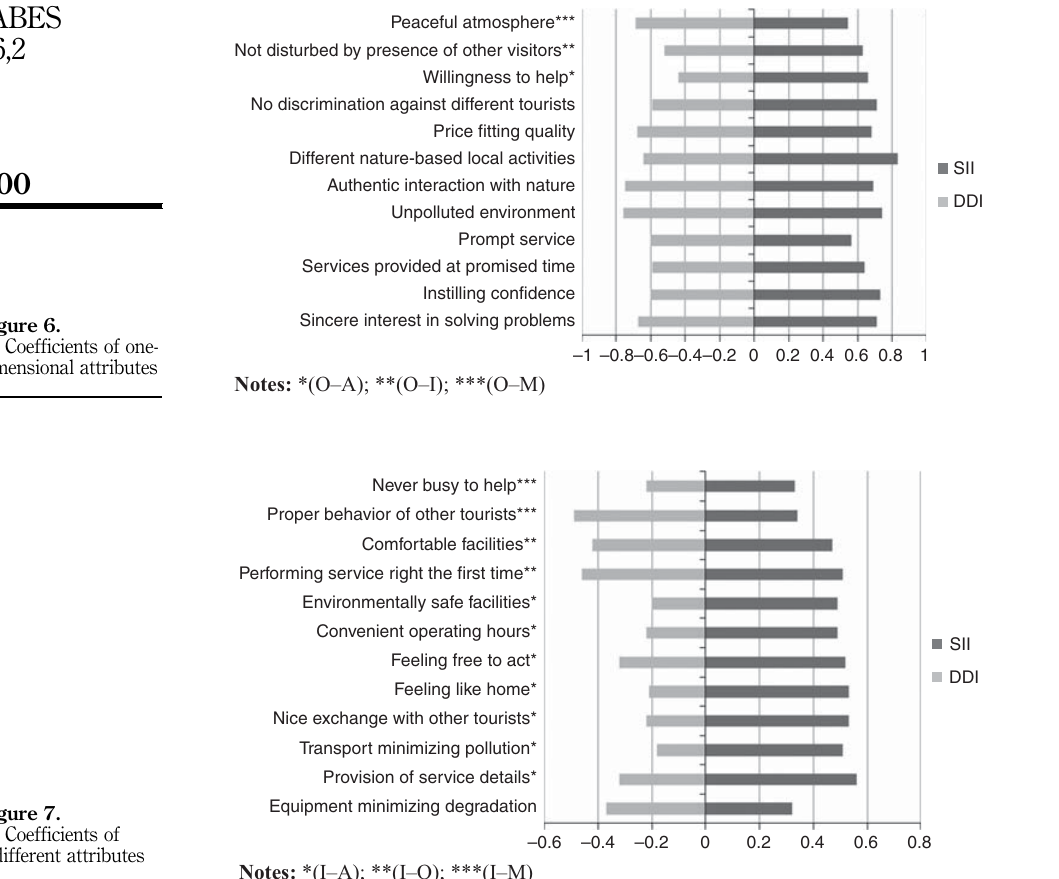
Figure 7. CS Coefficients of indifferent